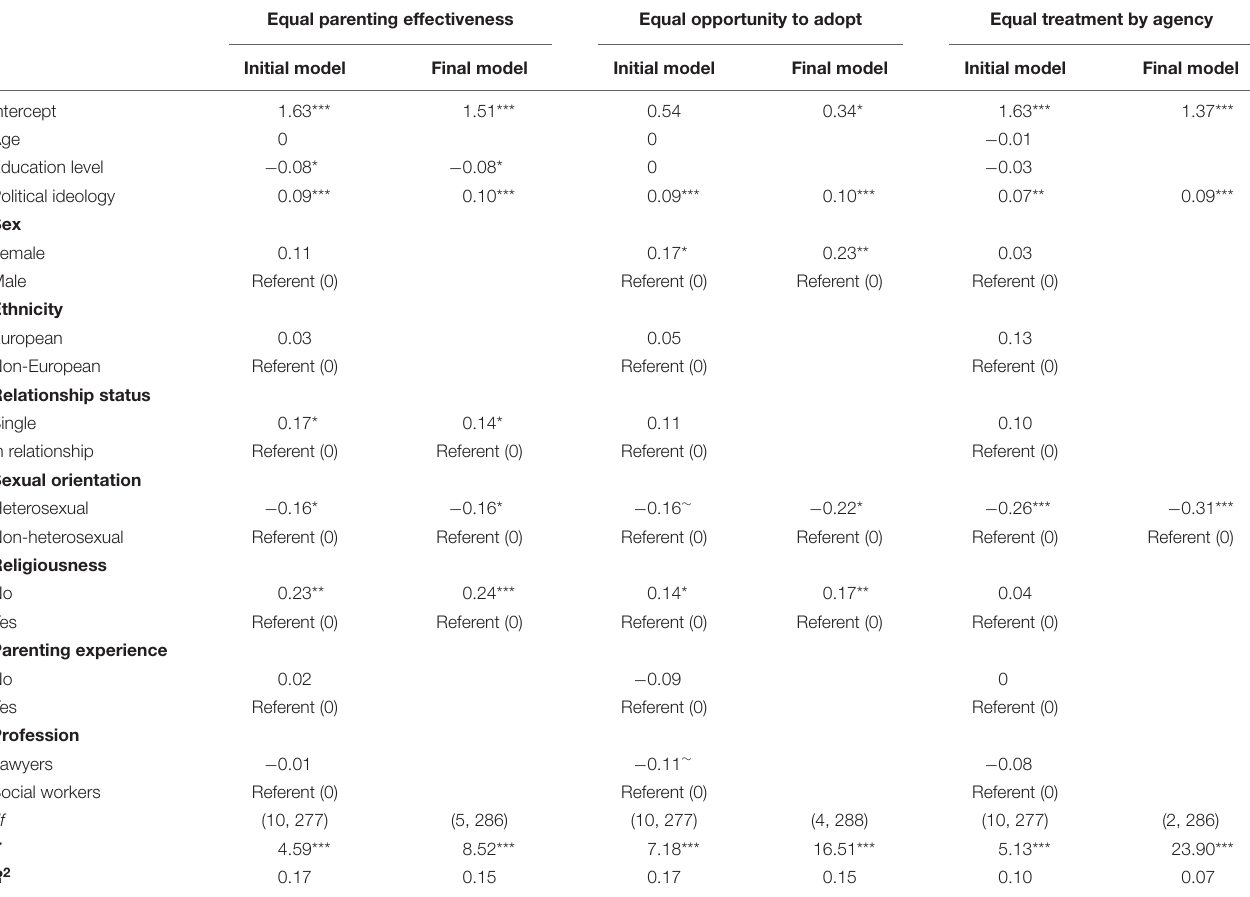
TABLE 6 | Summary of regression analysis predicting lawyers and social workers’ general perceptions on adoption by lesbian couples and gay couples ( N = 289). Equal parenting